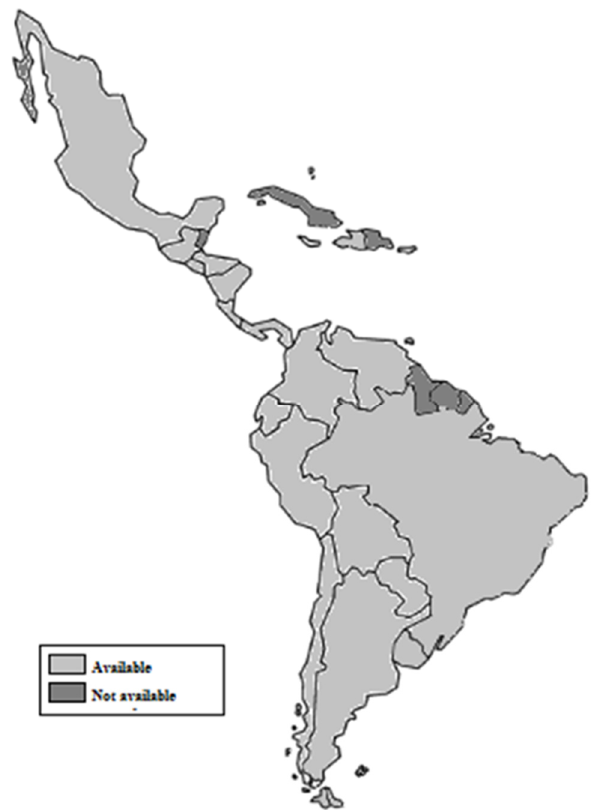
Figure 2. National regulations on infant formula marketing in Latin America available or